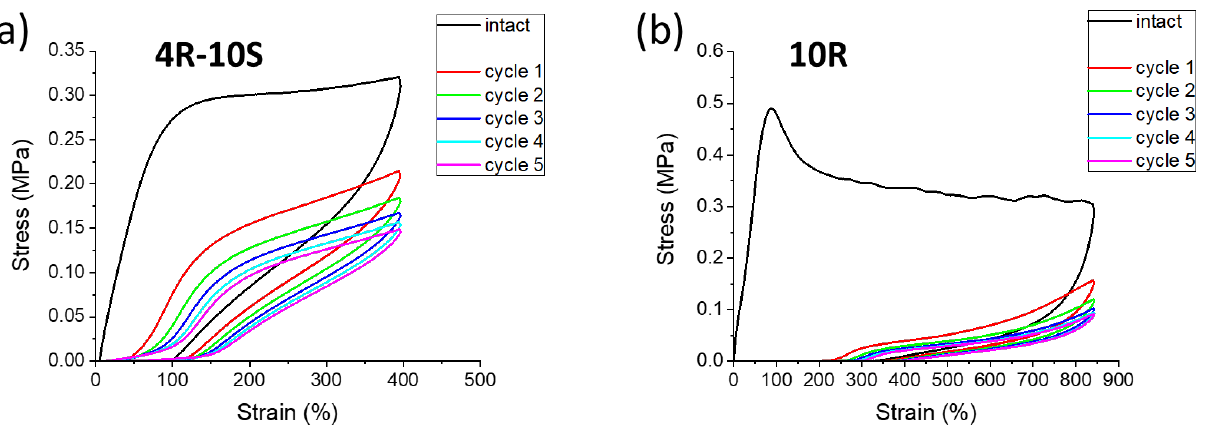
Figure 12. Repeated cyclic loading test for selected samples: ( a ) 4R-10S; ( b ) 10R; both graphs are maximally zoomed and have different X and Y scales; the comparison shows the different nature of response to cyclic loading.